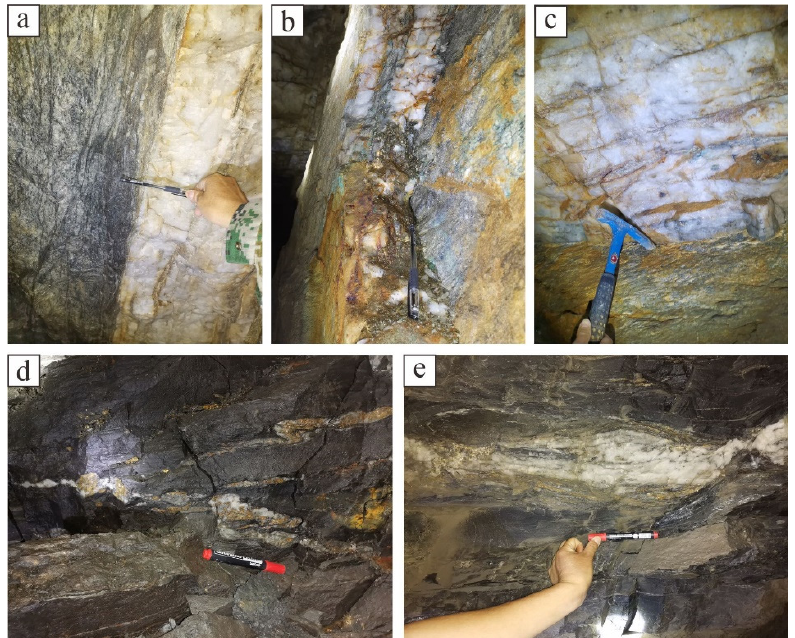
Figure 5. Photographs of ore bodies in the Jianbeigou deposit showing: ( a ) Au-bearing quartz veins controlled by ductile shear zone in granite; ( b ) quartz-polymetallic sulfide vein; ( c ) shear band structures developed in quartz veins; ( d ) sub-horizontal Au-bearing quartz vein; ( e ) lenticular vein body.